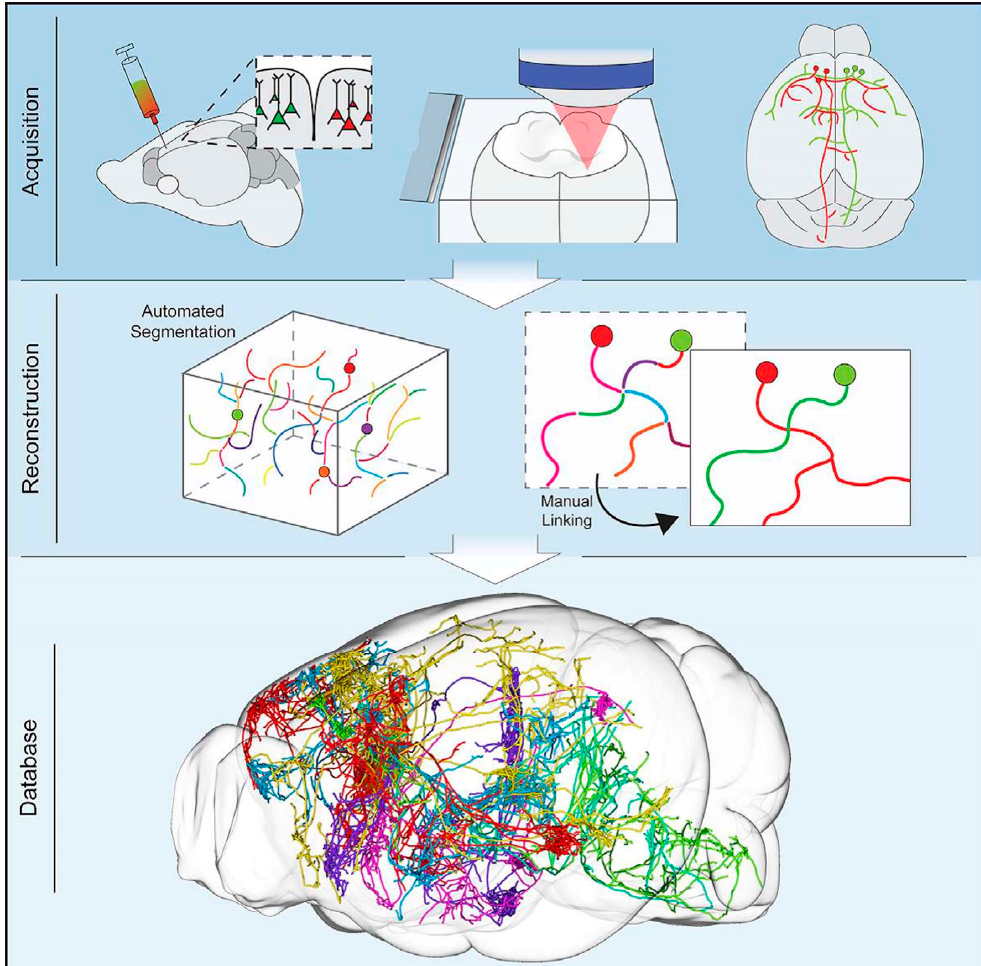
Figure 5. Schematic representation of 1000 projection neurons reconstruction deciphering new cell types and long-range connectivity organization present in mouse brain. Reprinted with the permission of [77].